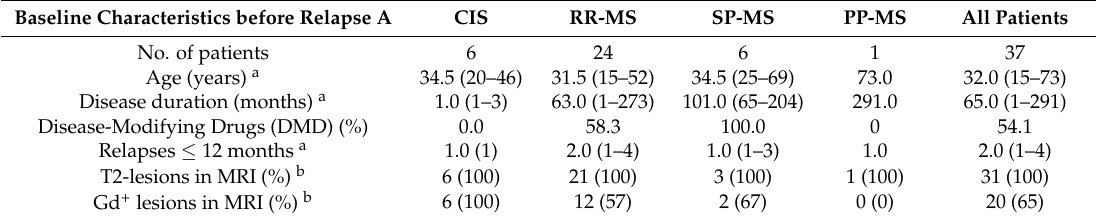
Table 1. Baseline characteristics of patients with clinically isolated syndrome (CIS) and Multiple sclerosis (MS) before treatment of relapse A.